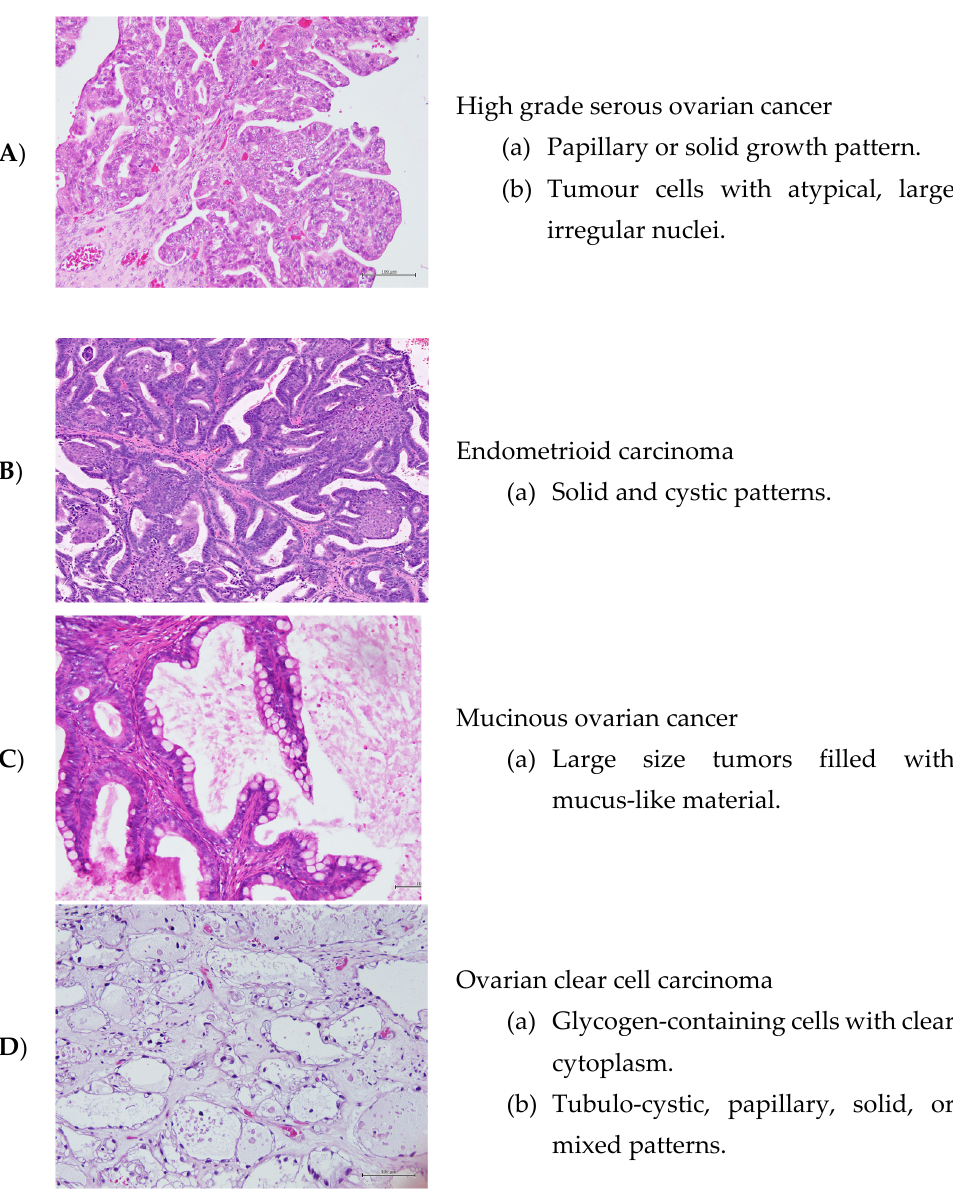
Figure 1. Hematoxylin and Eosin staining of the ovarian cancer tissues (under magnification of ×